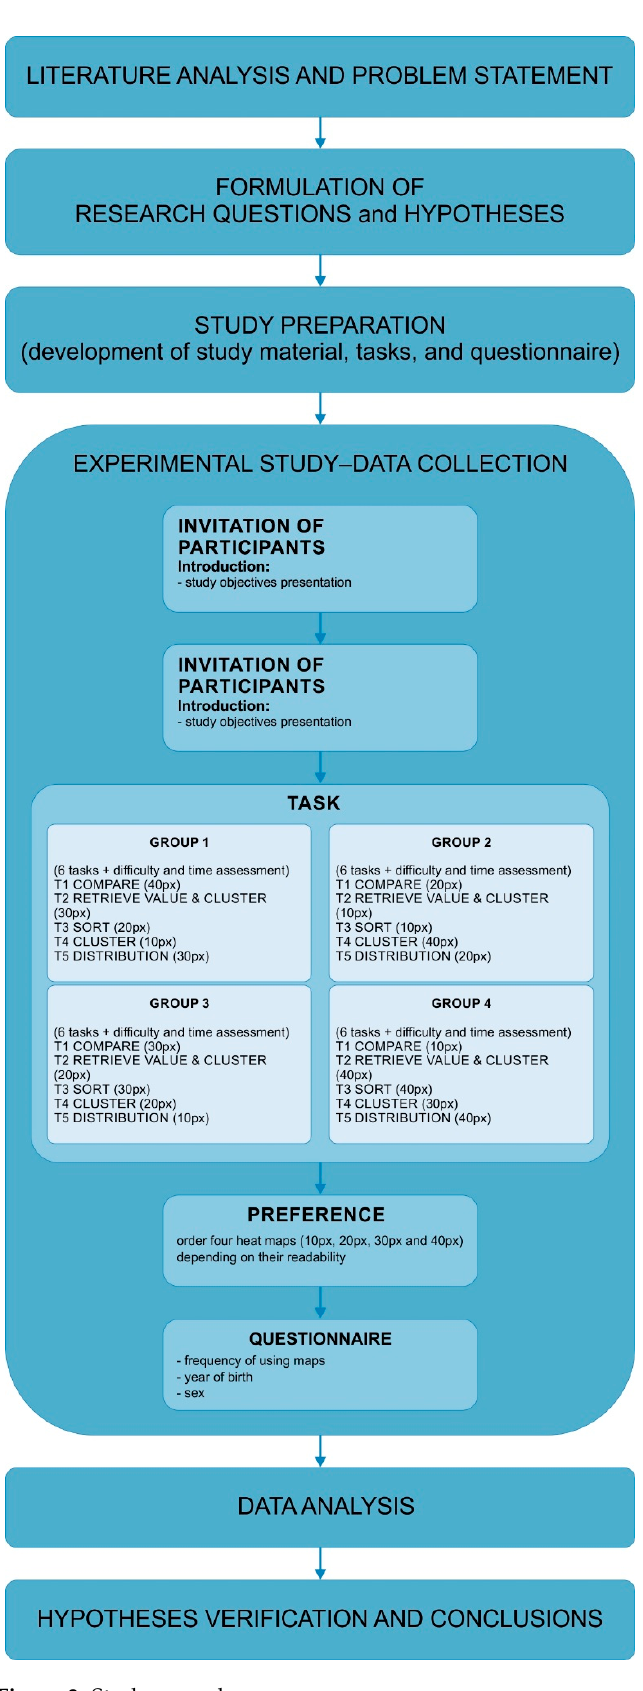
Figure 3. Study procedure.